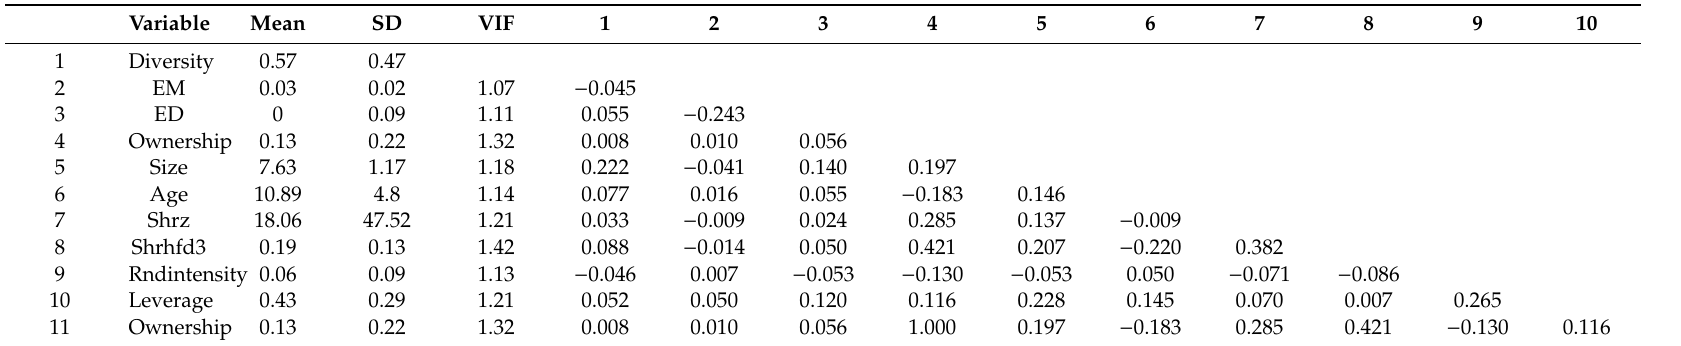
Table 1. Descriptive statistics and zero-order correlations abc.